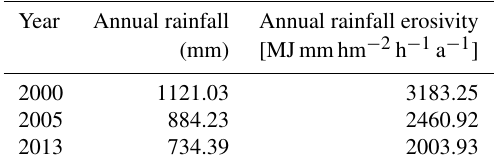
Table 1. The rainfall erosivity factor ( R) in Yinjiang during the study